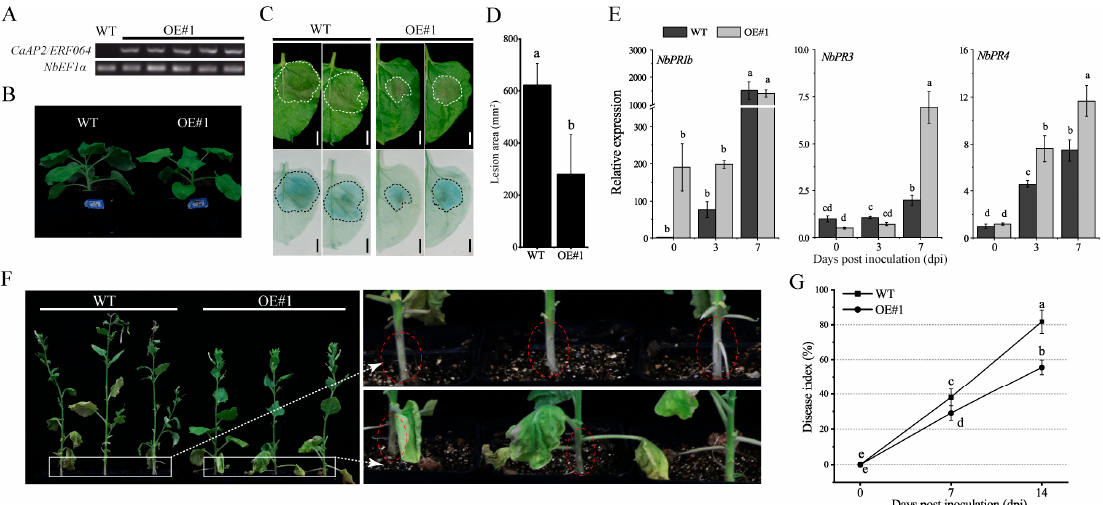
Figure 6. CaAP2/ERF064-OE tobacco plants show enhanced resistance to P. capsici . ( A ) Expression of CaAP2/ERF064 in OE and wild-type (WT) plants. ( B ) Phenotype of OE and WT plants. ( C, D ) Disease symptoms and analysis of lesion area at 3 dpi. ( E ) Expression analysis of defense-related genes after P. capsici infection. ( F ) Phenotypes of OE and WT plants after P. capsici inoculation at 7 dpi. Circles indicate the shrinkage of the stem. ( G ) Disease index percentage. Values are means ± SD. Small letters indicate a significant difference (LSD, p < 0.05).